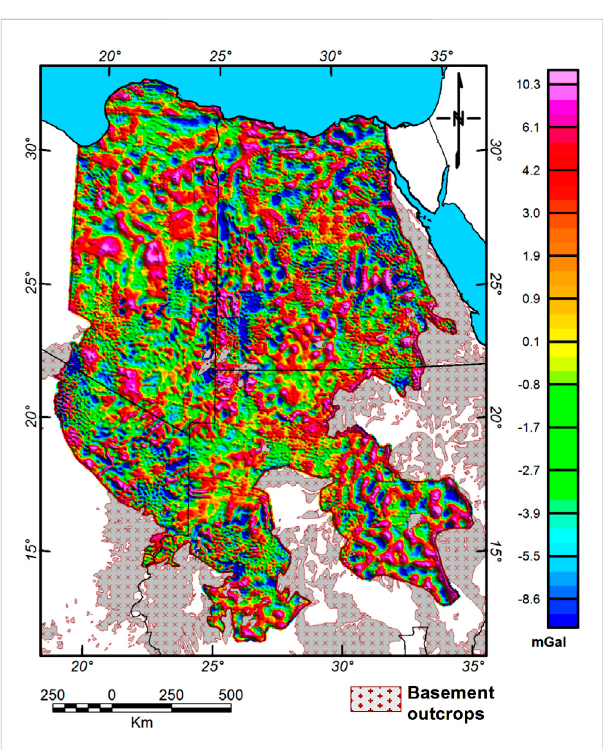
FIGURE 5 Residual gravity anomaly map after removing of the regional